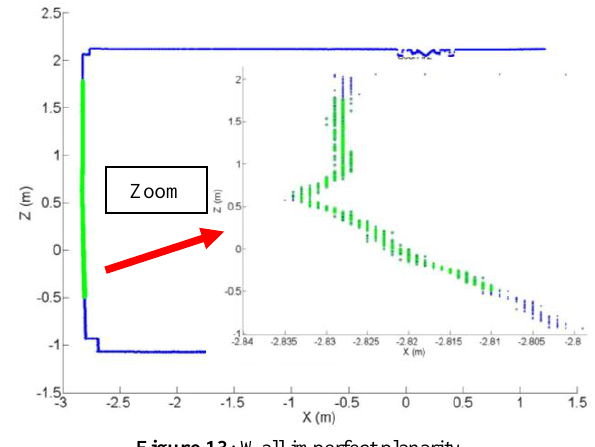
Figure 13 : Wall imperfect